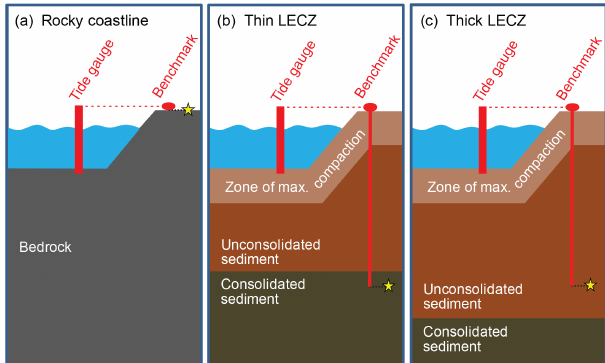
Figure 1. Schematic of a tide gauge and associated benchmark on a rocky coastline (a) , a thin LECZ (b) , and a thick LECZ (c) . In all three environments, the tide gauge measures RSLR with respect to the base of the benchmark foundation, which is indicated by a star in each